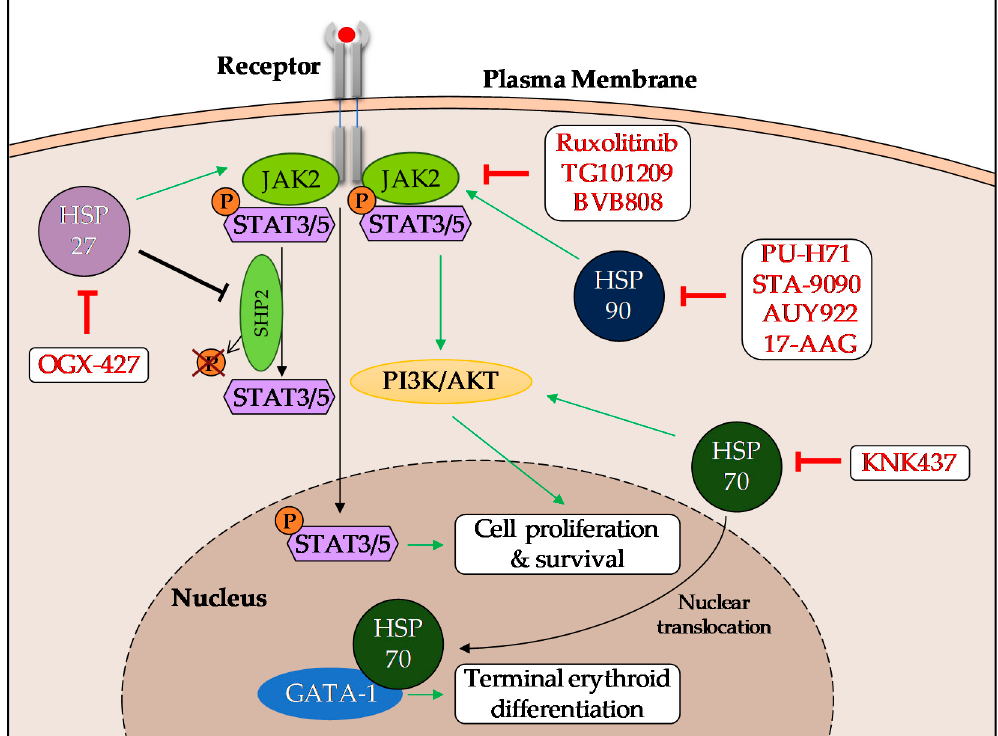
Figure 1. Role of HSPs and main known HSP interactions in MPN. HSP27 interacts with JAK2/STAT5 and prevents the SHP2-dependent de-phosphorylation of STAT5. HSP90 contributes to JAK2 stabilization and HSP70 activates the downstream target PI3K/AKT. Both HSP70 and HSP90 are also involved in inflammation, especially through an indirect regulation of NF- κ B.